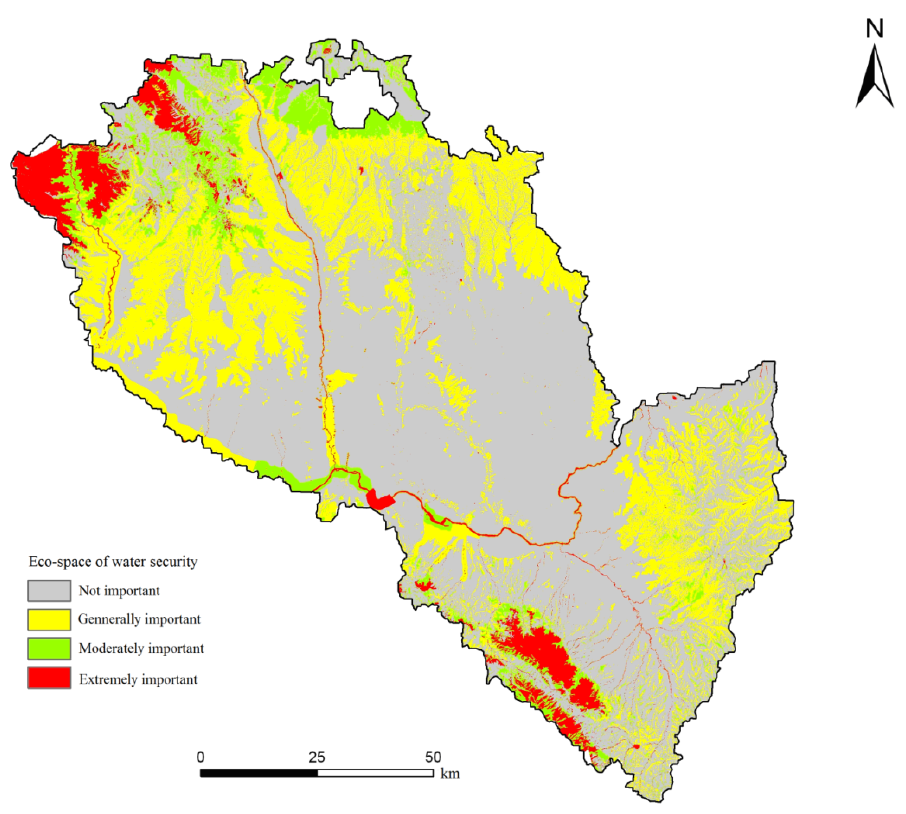
Figure 4. Evaluation results of the importance of water security eco-space in Lanzhou